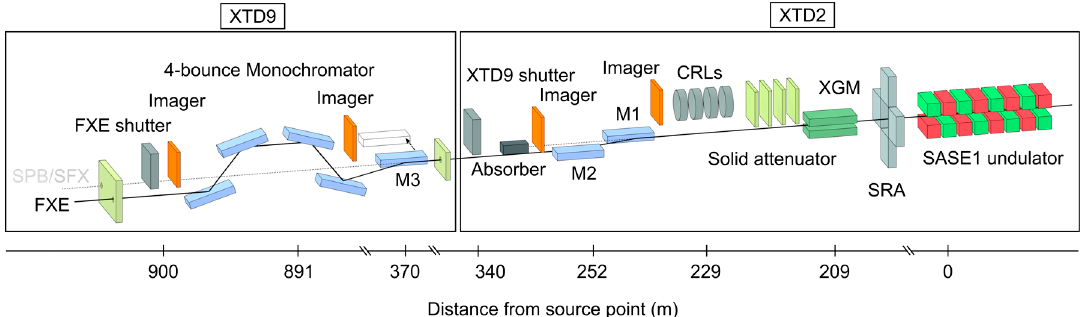
Figure 1. The 900 m long X-ray beam path in the photon transport tunnel sections (XTD2 and XTD9) from the SASE1 undulator exit (at the right) to the experimental hall (left end). The spontaneous radiation aperture (SRA) defines the FEL beam path. The beam is collimated by CRLs to an X-ray energy dependent beam size of about 1 mm. Beam imagers and a gas-based intensity position monitor (XGM) measure the beam profile, intensity and location. A set of three X-ray mirrors (M1, M2 and M3) reject the background radiation and bring the beam into the FXE experimental hutch [32].